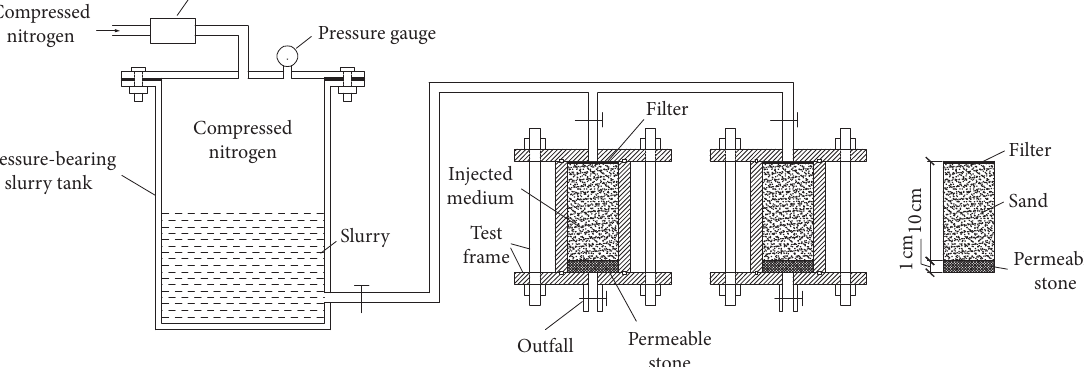
Figure 1: Principle of the grouting test device.